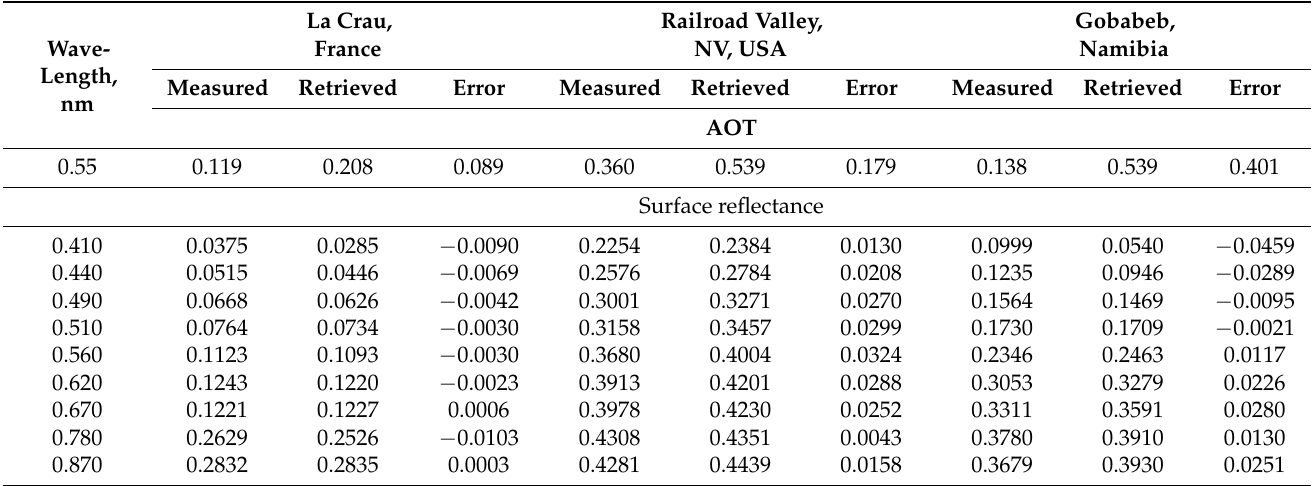
Figure 10. Spectral reflectance of the surface at test sites La Crau, France (LCFR), Railroad Valley, NV, USA (RVUS), and Gobabeb, Namibia (GONA) according to ground measurements (solid lines) and data retrieved with RACE algorithm (dashed lines). Table 16. The results of retrieving spectral reflectance of surfaces with the RACE algorithm in comparison with the data of reflectance ground